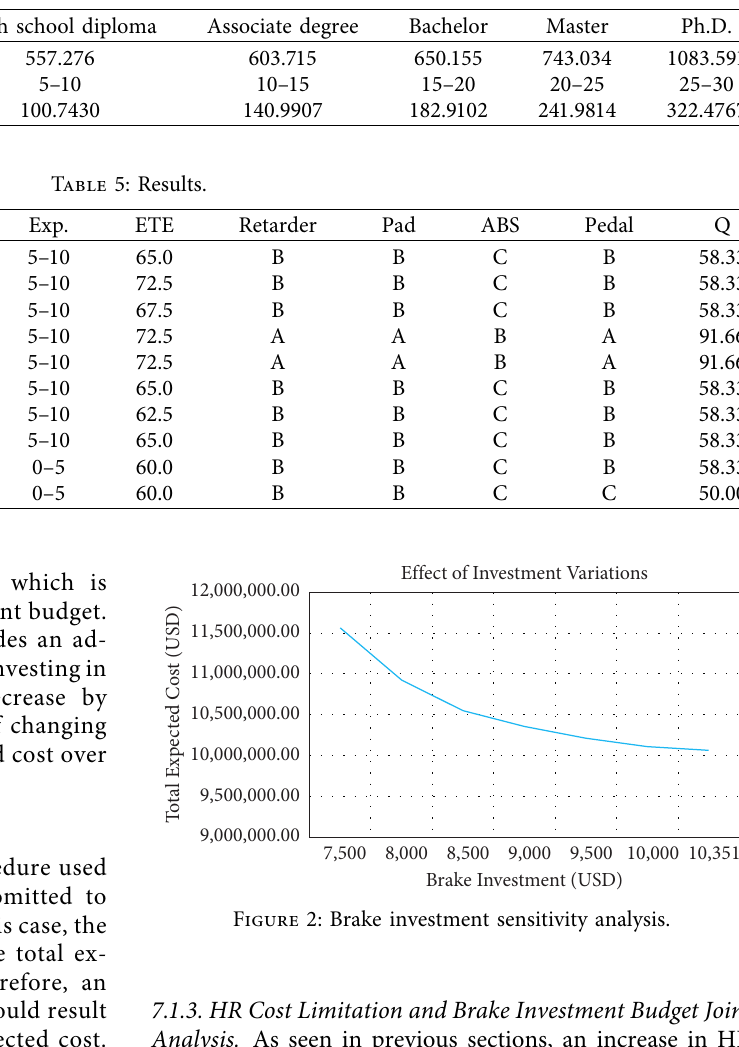
Table 4: Salary per month of drivers (USD).